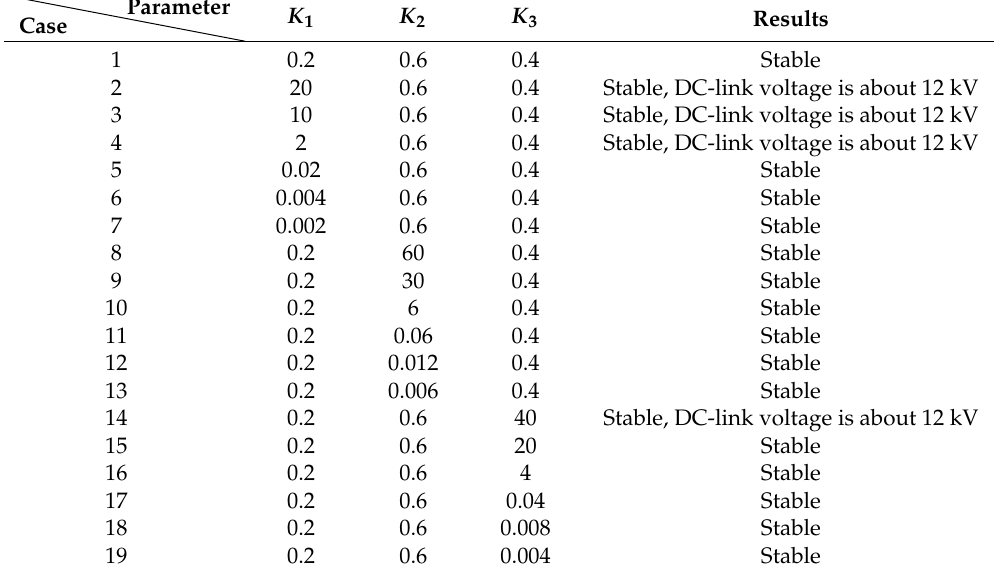
Table 7. Parameter effect based on H ∞